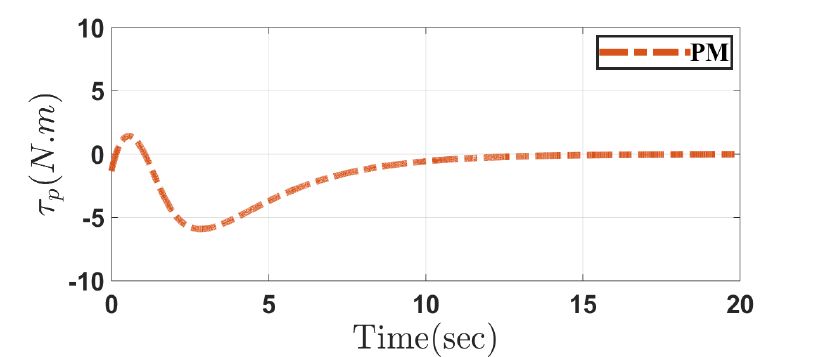
Figure 9. Input torque of movable mechanism in the proposed method (PM) in Case 1.